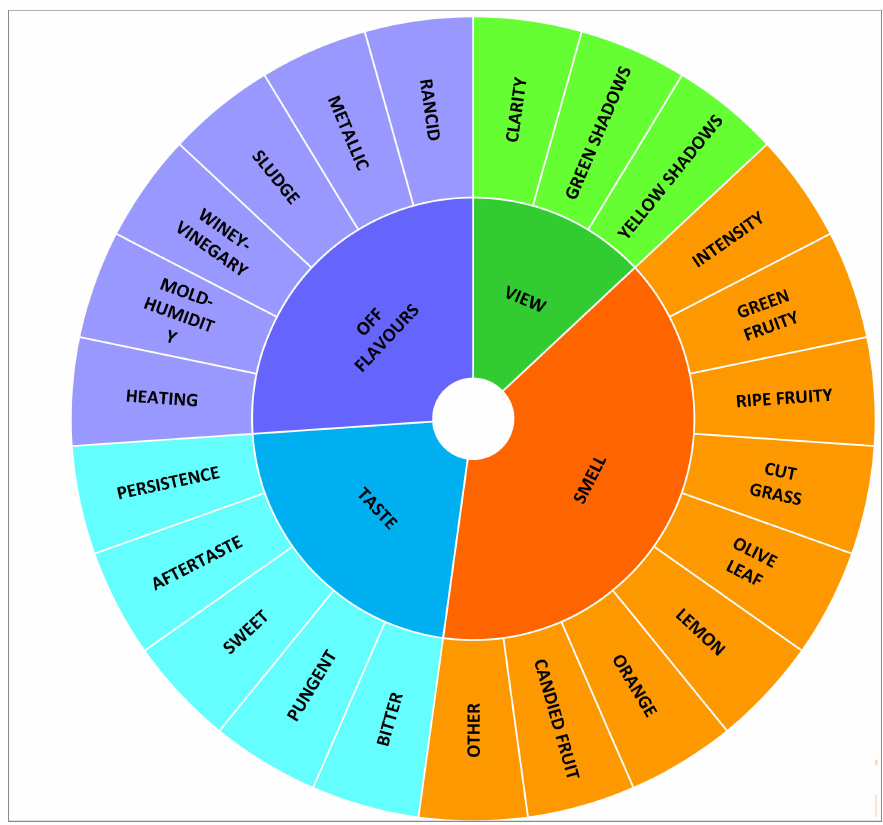
Figure 1. Sensory wheel developed for the descriptive evaluation of Citrus olive